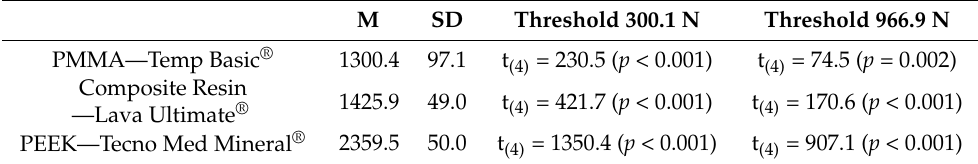
Table 6. Comparison of fracture resistance by material